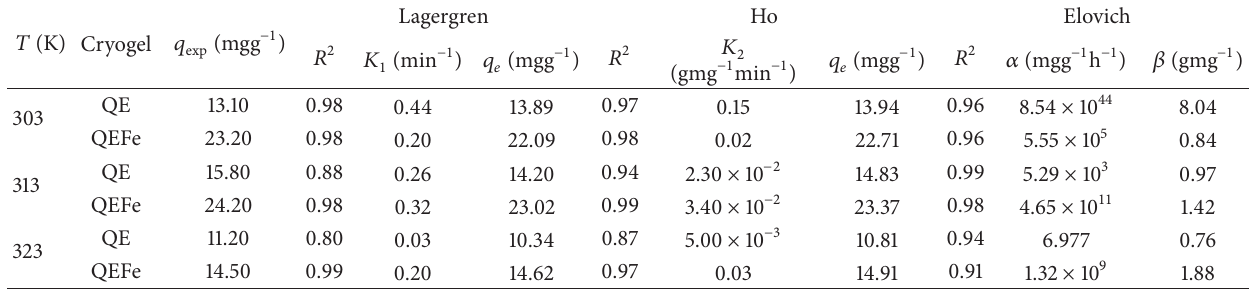
Table 1: Summary of kinetics models.